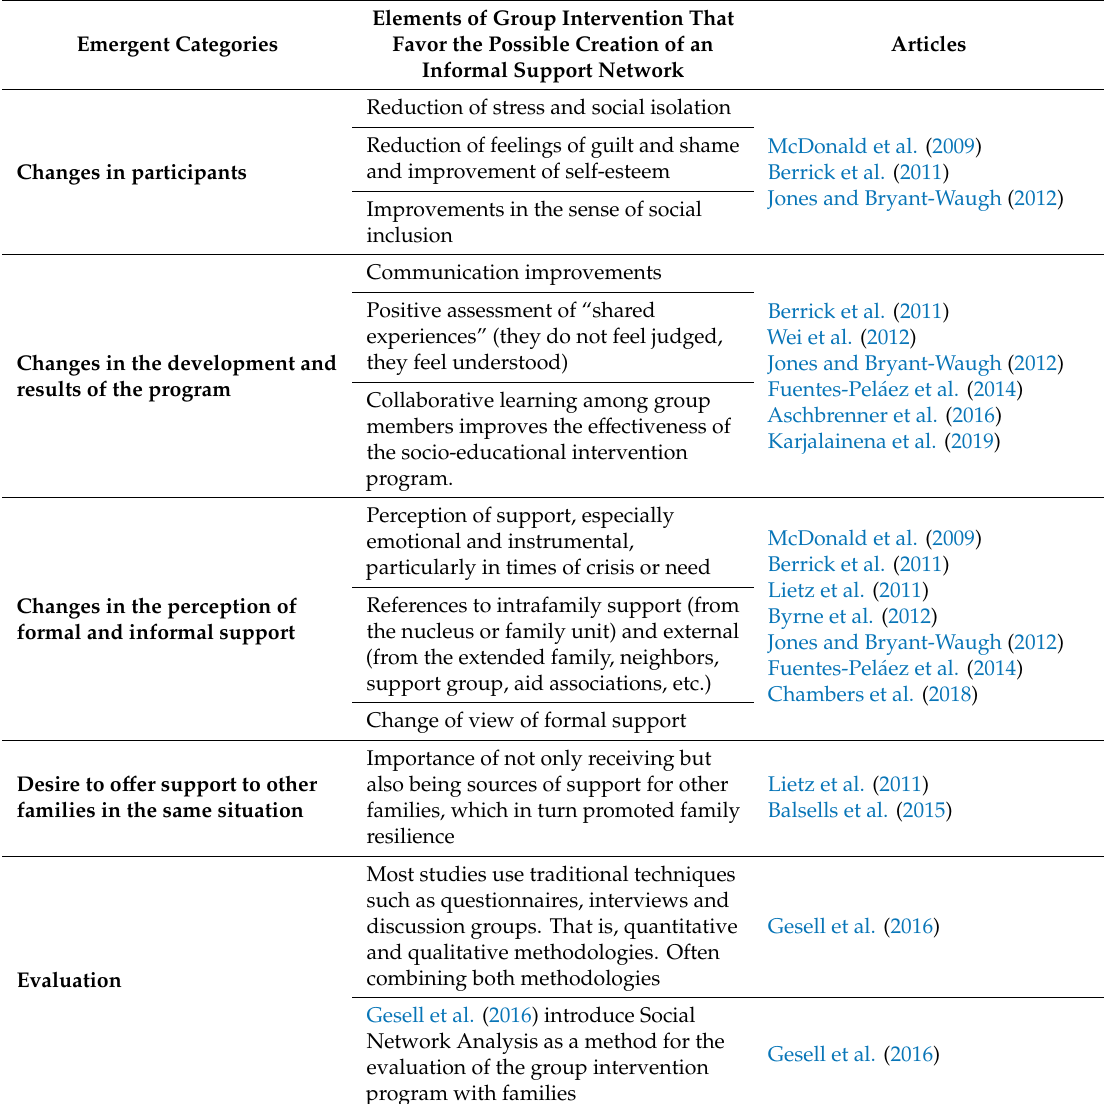
Table 3. Elements identified in the selected